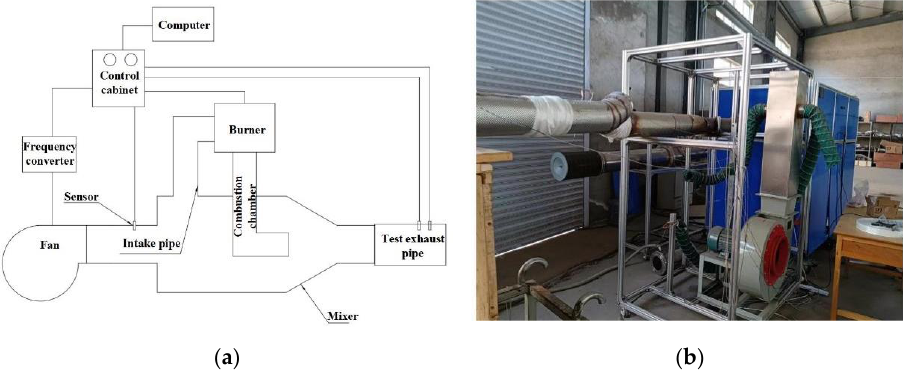
Figure 3. The temperature measurement experimental system. ( a ) Schematic of temperature measurement system. ( b ) Temperature measurement test.